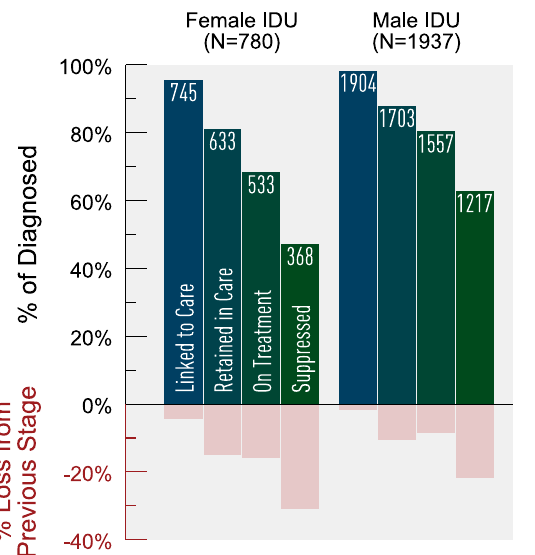
Fig. 6. Estimated HIV cascade of care for IDU by sex in 2011 for British Columbia. *IDU 5 history of injection drug use.